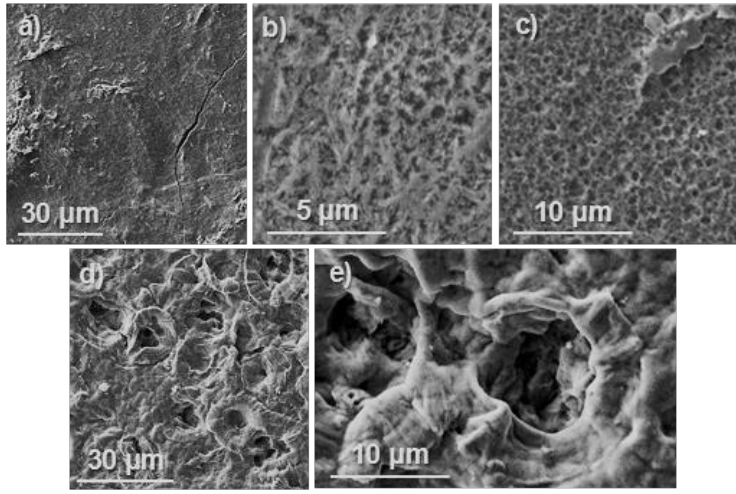
Figure 9. SEM micrographs showing surface texture of poly(glc-6-glc 6) films exposed to PBS for 408 h ( a ); lipase for 217 h ( b ); proteinase K for 217 ( c ) and 312 h ( d ). A